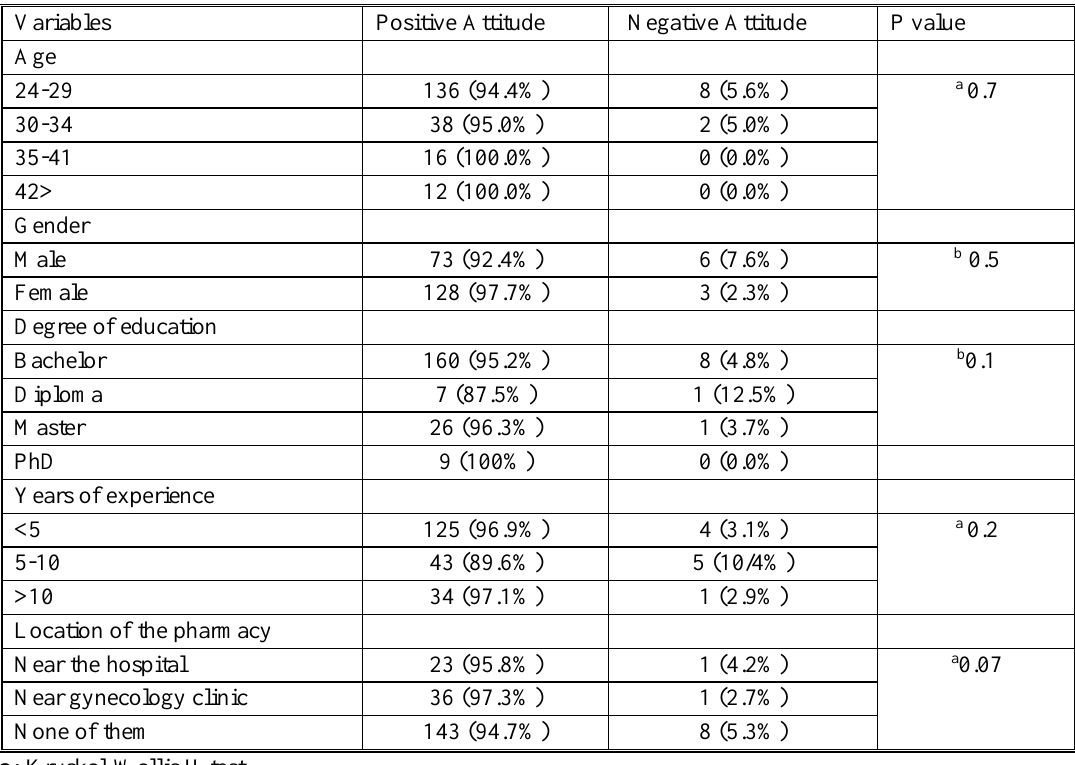
Table 5. Association between sociodemographic characteristics and community pharmacists’ attitude level.